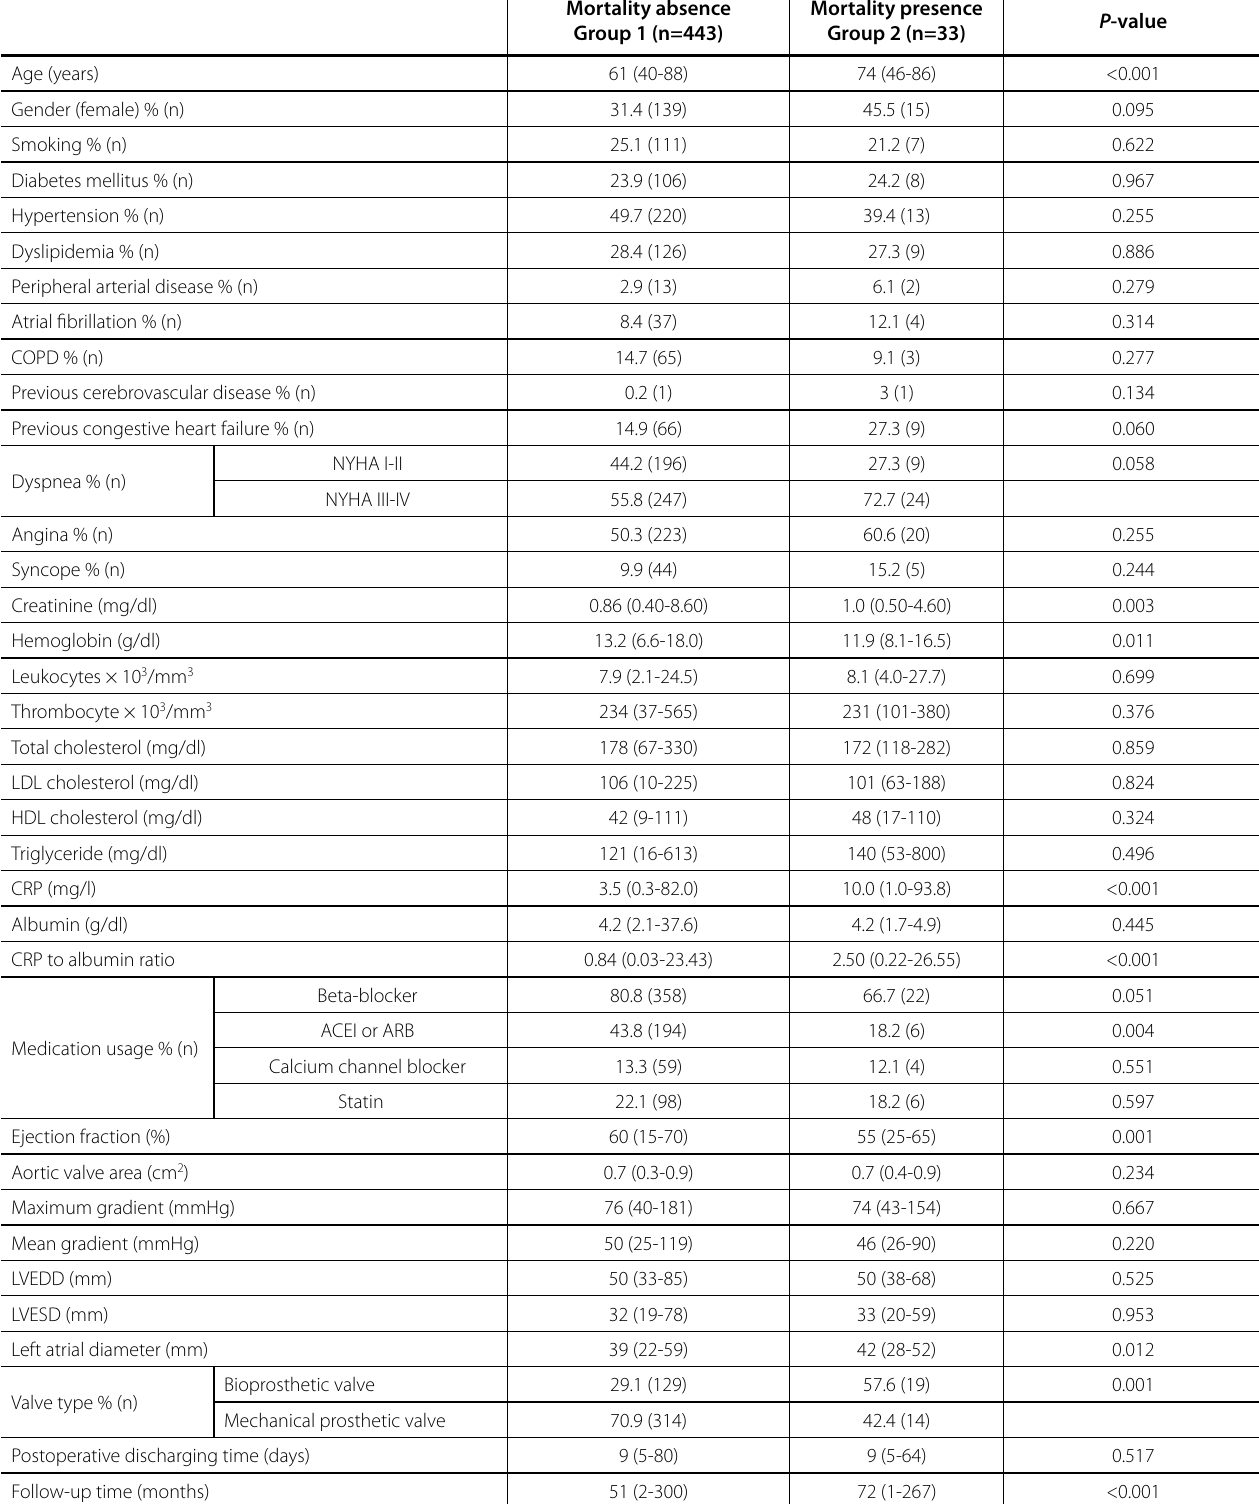
Table 1 . Basal demographic and clinical variables of both groups with mortality absence and presence during the follow-up time. Mortality